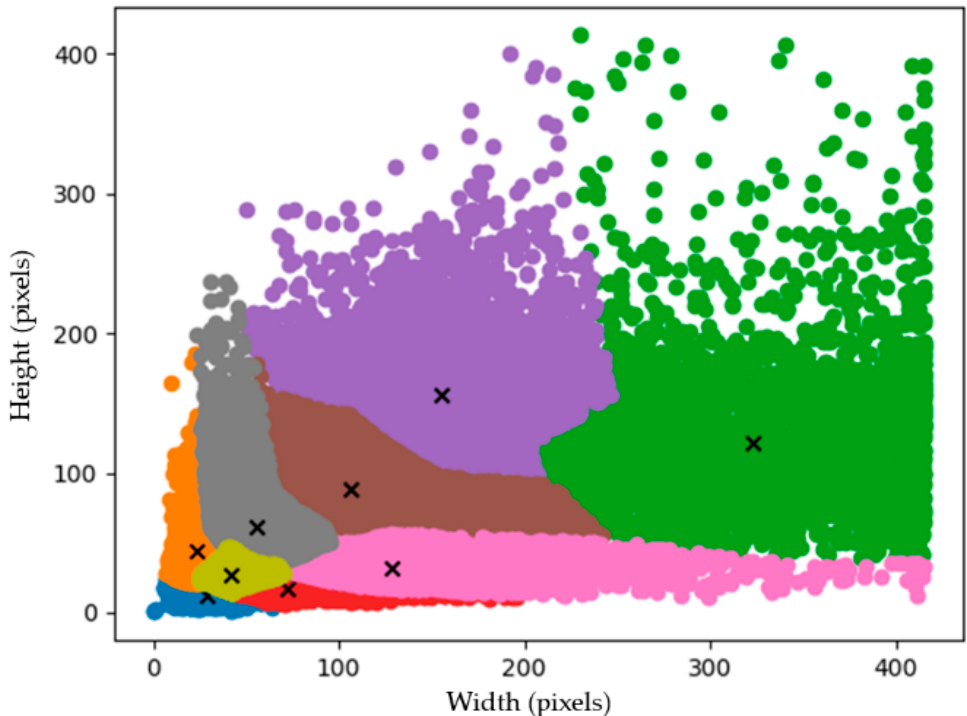
Figure 7. The clusters of height and width of the anchor boxes are derived by the K-means cluster- ing. Table 8. The anchor mask setting parameters derived from Figure 7.